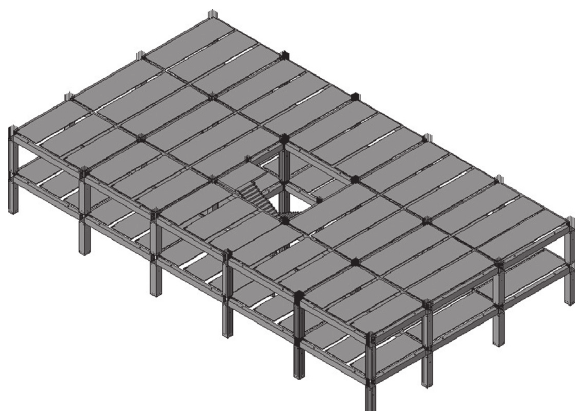
Figure 17: A sample case of prefabricated reinforced concrete frame building.